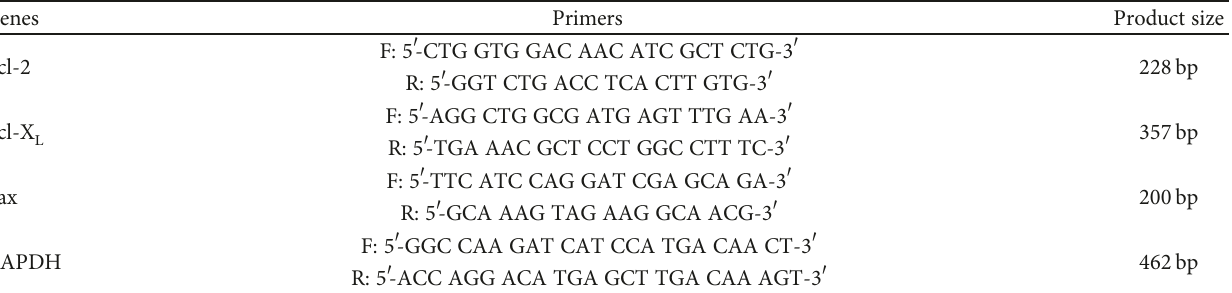
Table 1: Primers used and length of segments resulting from